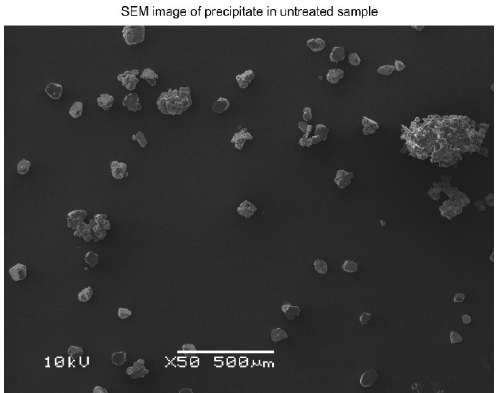
Figure 14. SEM image of precipitate found in the reference beakers. The length of the white bar is 500 µm.